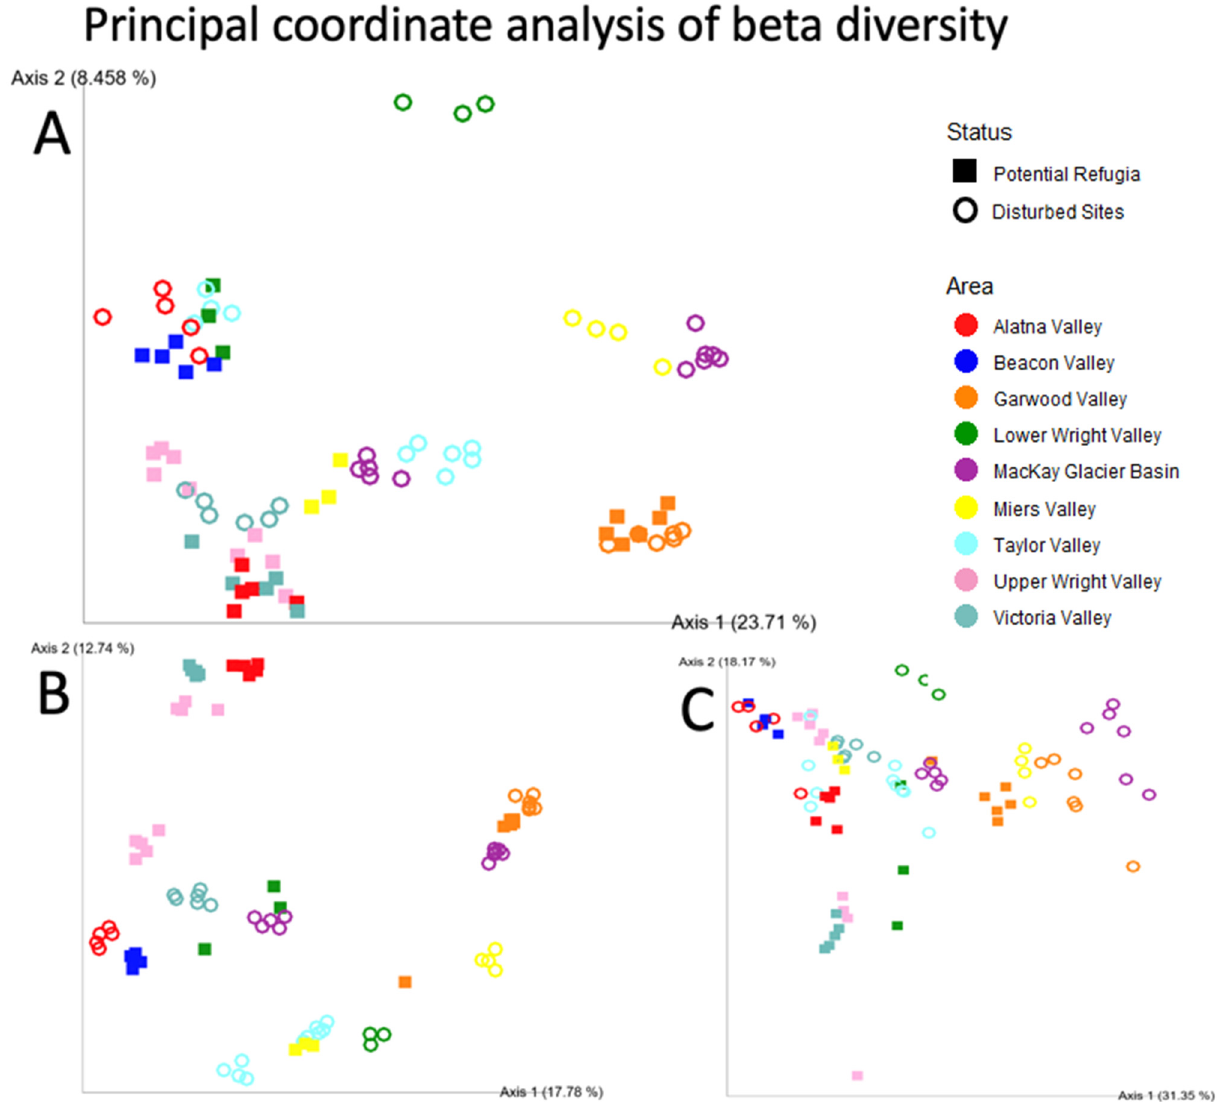
Figure 4. Principal coordinate analysis of beta diversity. Principal coordinate analysis of the beta diversity of each individual sample replicate for ( A ) Unweighted UniFrac distance, ( B ) Bray–Curtis distance and ( C ) Weighted UniFrac distance. Axes labels indicate the weight of the principal co- ordinate. Samples taken from putative refugia sites are shown as squares, disturbed sites are shown as open circles. Colors indicate the valley basin samples originate from.